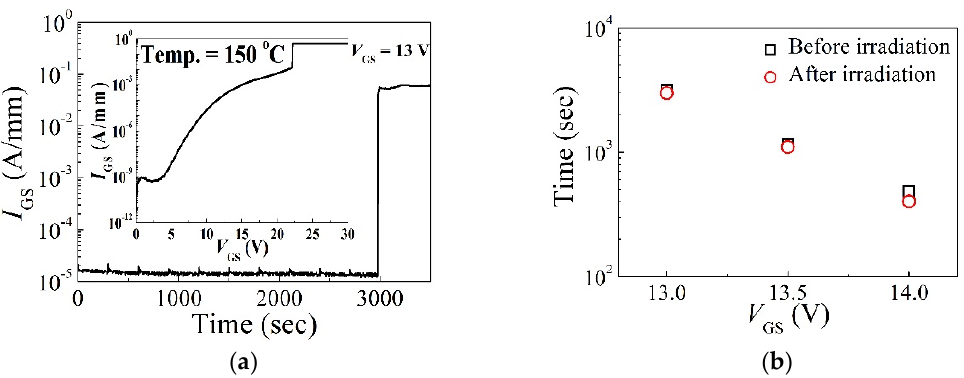
Figure 2. ( a ) The results of time-dependent dielectric breakdown (TDDB) characteristics carried out on one representative device (inset) time-zero breakdown (TZB) characteristics. ( b ) The V GS dependence of TDDB characteristics at 150 °C with V GS = 13, 13.5, and 14 V.